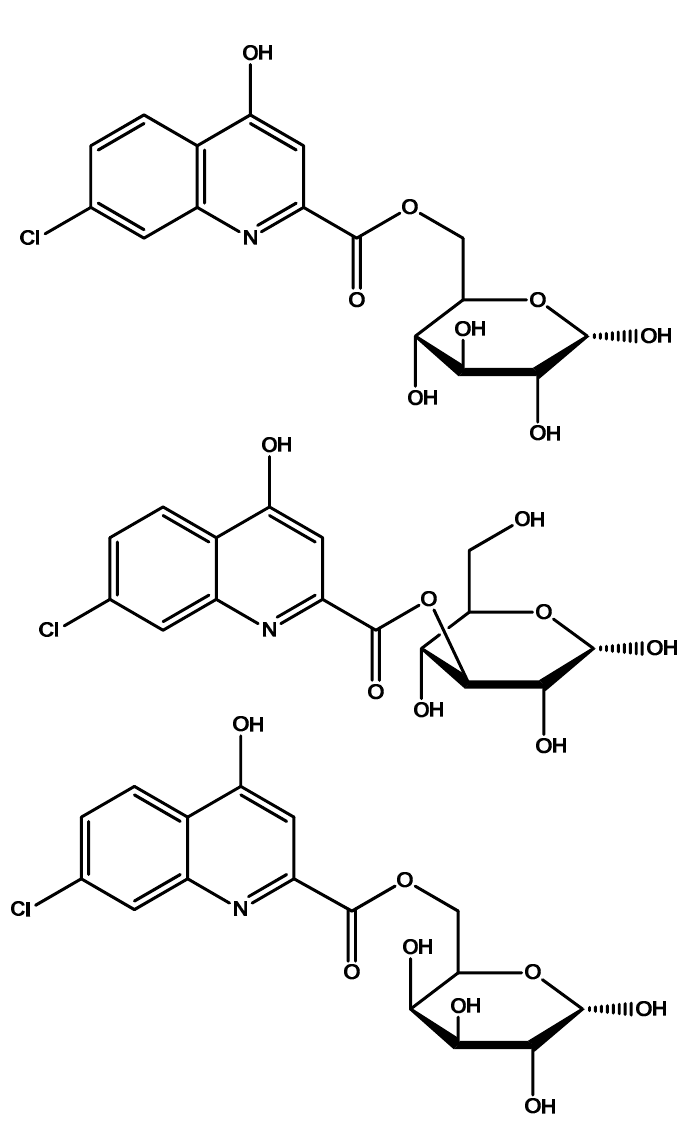
Figure 9. Chemical structures of glucose and galactose esters of 7-chlorokynurenic